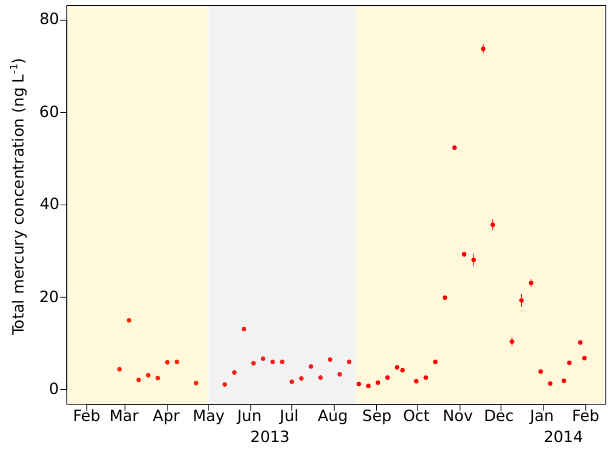
Figure 5. Total mercury concentration (ngL − 1 ), along with stan- dard errors, in surface snow samples collected weekly at Concordia Station from February 2013 to January 2014. Dark period (winter) highlighted in grey, sunlit period highlighted in yellow. Total mer- cury concentrations were elevated (up to 74ngL − 1 ) in November– December 2013 (summer). All samples were analyzed in replicates of three. Standard errors are frequently smaller than the width of the